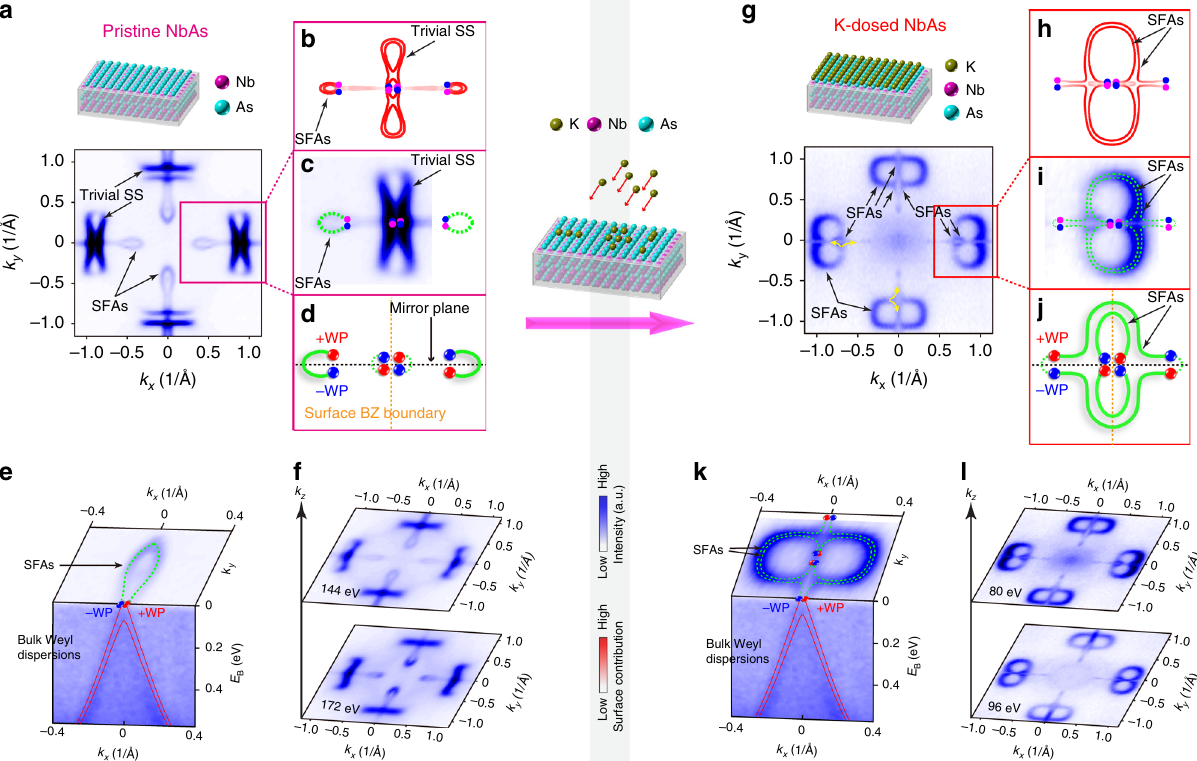
Fig. 2 FS comparison of pristine and potassium (K)-decorated NbAs. a FS of pristine NbAs consisting of SFAs and trivial surface states (marked as Trivial SS). b – c are the calculated and measured FS around the X point, respectively. d Sketch of the SFAs ’ connectivity to projections of Weyl points. e In pristine NbAs, SFAs connect projections of bulk Weyl points (upper image: surface FS showing the SFAs; lower image: bulk Weyl dispersions with overlaid calculated bulk dispersion). f two representative FSs measured with 144 and 172 eV photons show spoon-like and bowtie-like features of almost identical size, thus revealing their surface nature. g Figure-8-like FS of K-decorated NbAs consisting of long SFAs without trivial surface states. The overlaid yellow arrows show that the fi gure-8-like FS splits into two branches near k x = 0 and k y = 0 regions. h – i are the calculated and measured FS around the X point, respectively, which show good agreement. j The SFAs and connection pattern are schematically displayed. k In K-decorated NbAs, SFAs connect projections of bulk Weyl points (upper image: surface FS showing the SFAs; lower image: bulk Weyl dispersions with overlaid calculated bulk dispersion). l Two representative FSs measured with 80 and 96 eV photons, show fi gure-8-like features of almost identical size, thus revealing their surface nature. Horizontally polarized photons are used as they produce high intensity signals and clearly reveal all band structure features. (Note that the color scale of the calculated bands represent their surface projection, i.e., the bold red curves represent the surface states while the faded red curves represent bands with strong bulk